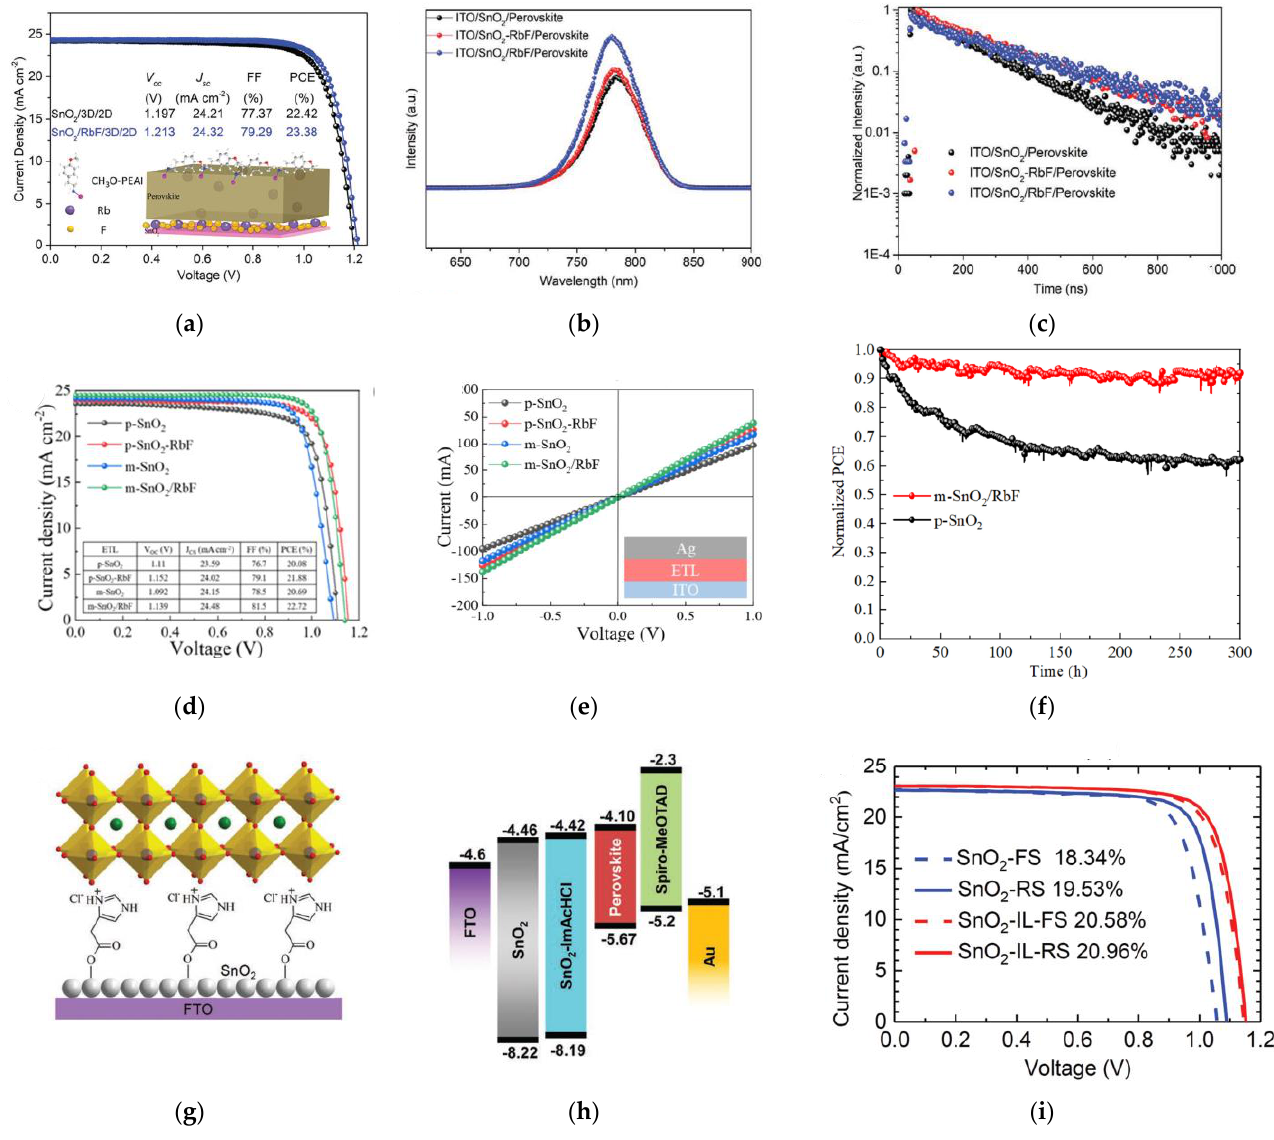
Figure 3. ( a ) Illuminated J - V curves under 1 SUN for forward- and reverse-voltage scanning of SnO 2 and SnO 2 /RbF-based PSC devices. ( b ) Steady-state PL and ( c ) TRPL spectra of perovskite films on various ETLs. Reproduced from [40] with permission from Wiley, 2021 ( d ) Illuminated J - V curves under 1 SUN for PSCs based on various ETLs. ( e ) Current vs. voltage ( I - V ) characteristic curves for various ETLs with an ITO/ETL/Ag structure. ( f ) Long-term maximum power point tracking (MPPT) stability measurements of devices with different ETLs under continuous 1 SUN illumination (simulated by LED light). Reproduced from [41] with permission from Elsevier, 2022. ( g ) Schematic illustration of formation of ImAcHCl-modified SnO 2 ETL. ( h ) Energy-band diagram of each layer in PSCs. ( i ) Illuminated J - V curves under 1 SUN for various ETLs. Reproduced from [42] with permission from Wiley,